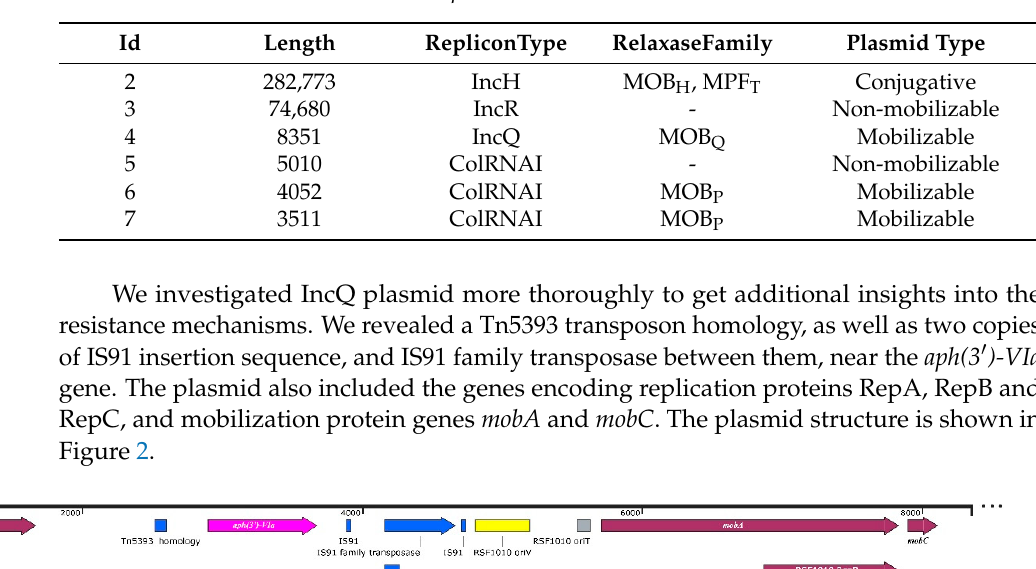
Table 1. Plasmid data for the clinical K. pneumoniae isolates studied.